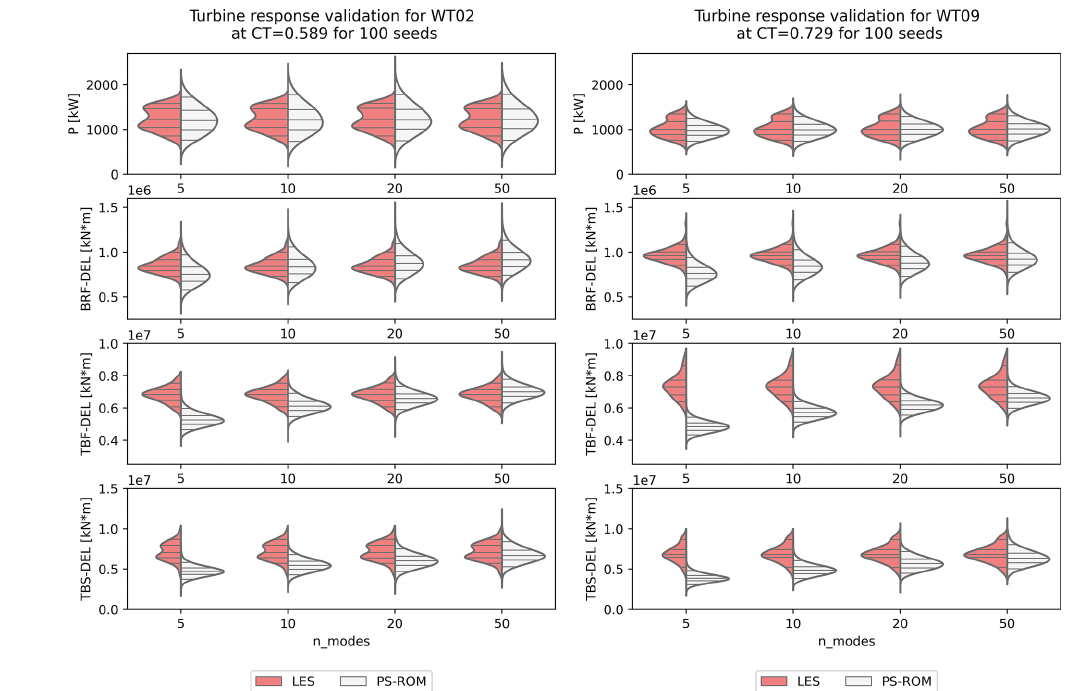
Figure 14. Distributions of 10min mean power and 1Hz damage equivalent load (DEL) of blade root flapwise (BRF), tower fore–aft (TBF), and tower side–side (TBS) bending moments for LES and for PS-ROM with 5, 10, 20, and 50 modes. Prediction at validation case, not used in the training of PS-ROM. Horizontal lines corresponds to 5th, 25th, 50th, 75th, and 95th percentiles. The statistics from PS-ROM is based on 100 random realizations of time series of 13107s long corresponding to 2 17 flow snapshots. WT02 is shown on the left and WT09 on the